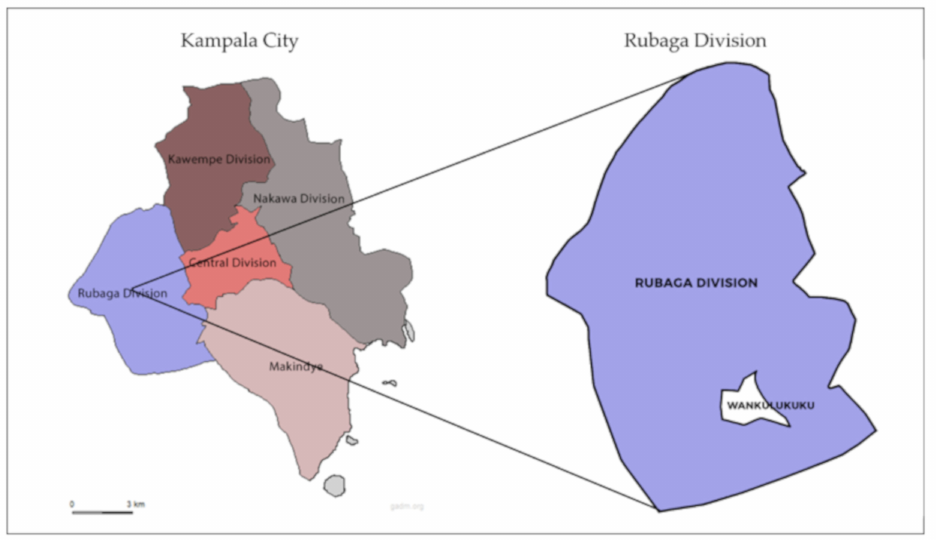
Figure 1. Location of study